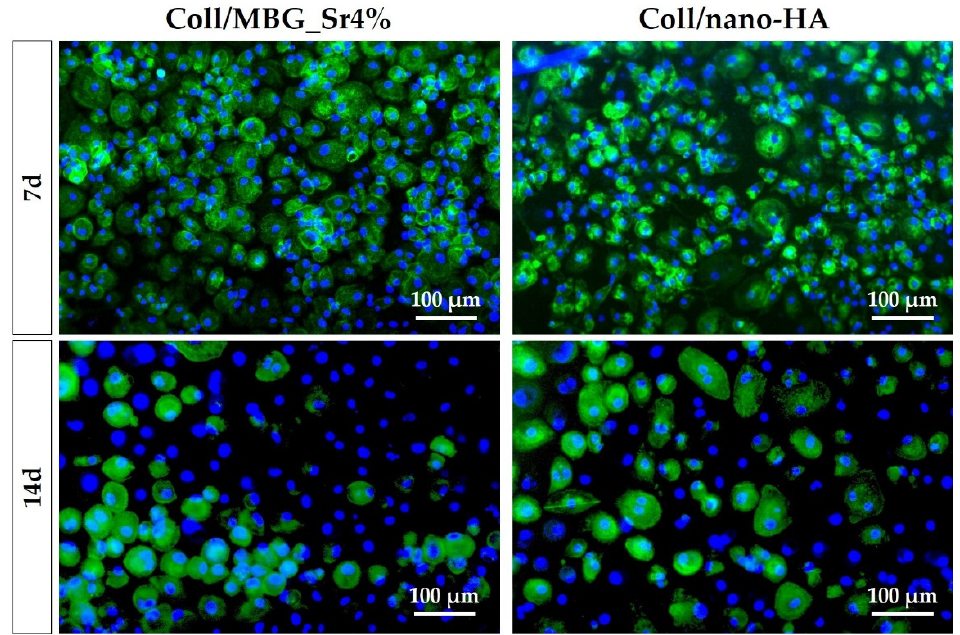
Figure 11. Fluorescence micrographs of PBMCs/pre-OCs on transwells co-cultured with OB-loaded materials at 7 and 14 days. Cytoskeletal actin and multinuclearity are stained with Phalloidin-FITC and Hoechst 33258, respectively.